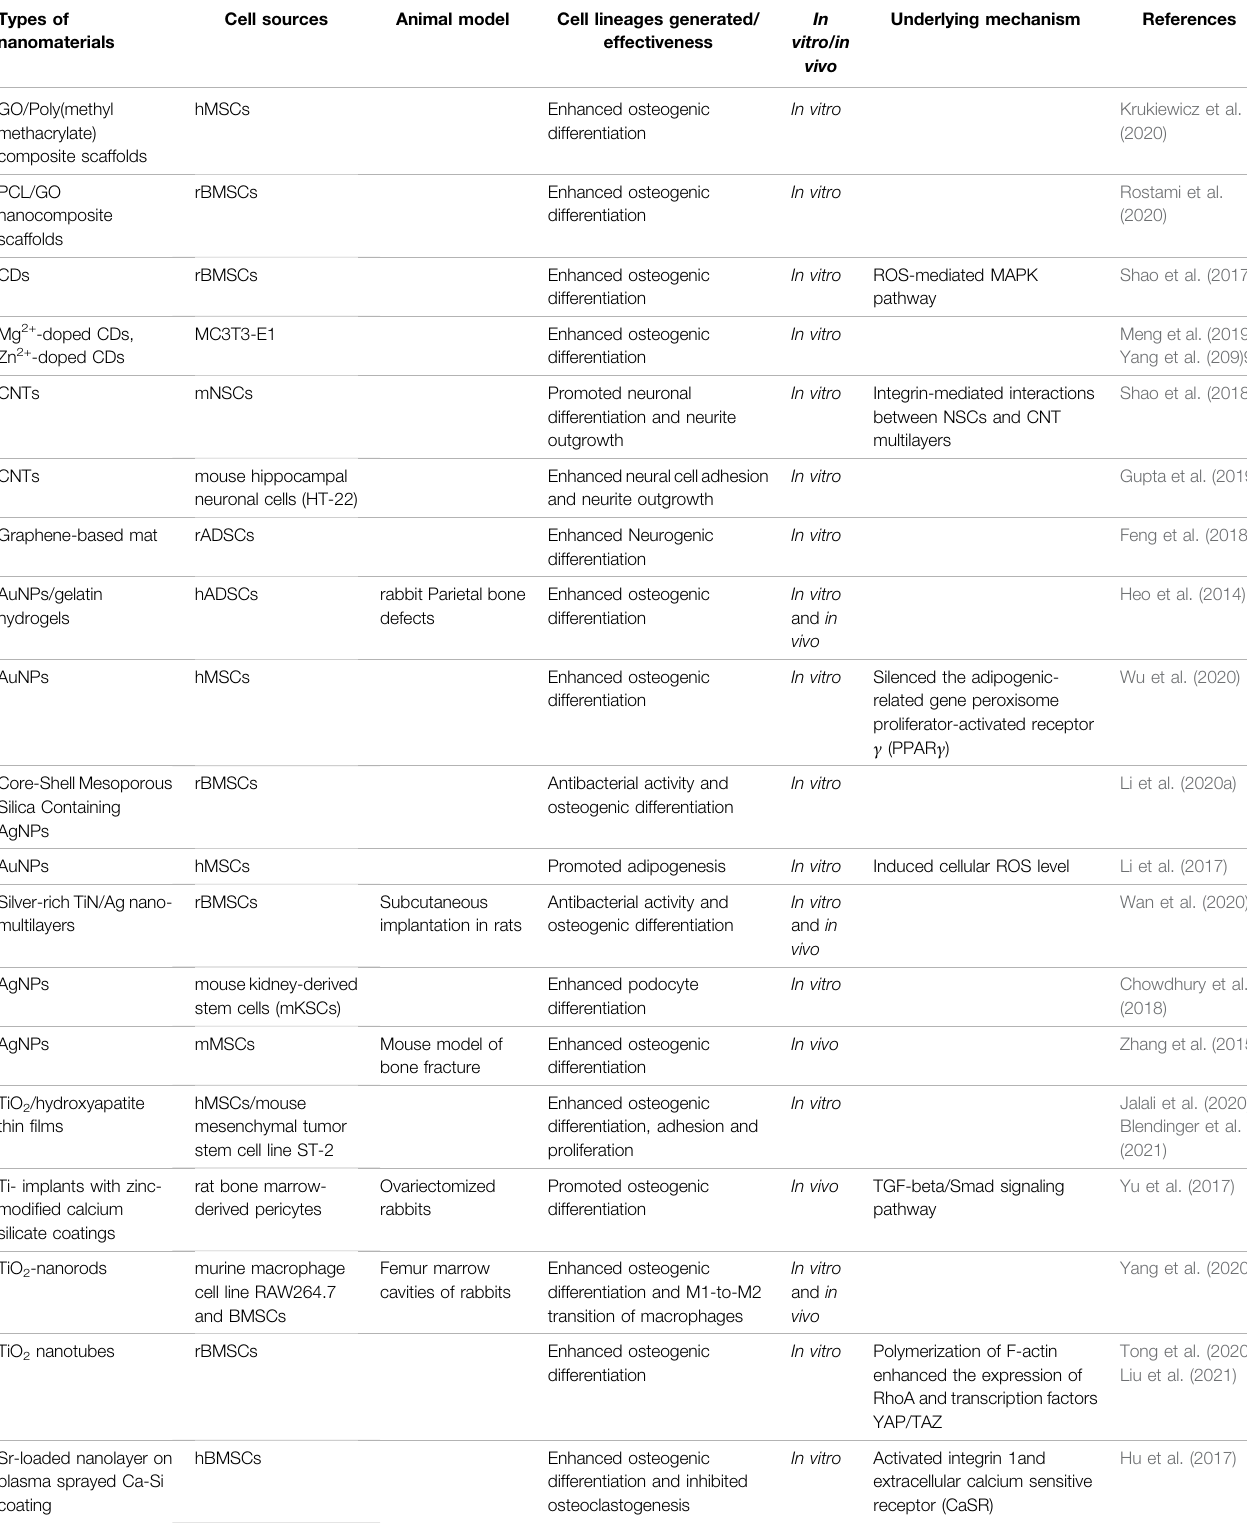
TABLE 1 | A summary of inorganic nanomaterials guiding stem cell differentiation and its application in regenerative